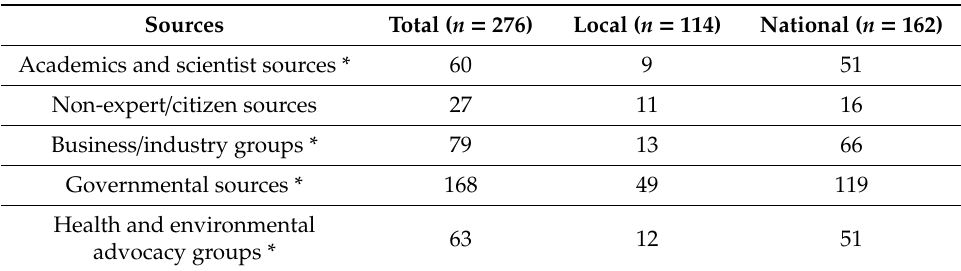
Table 2. Information sources cited in news coverage of air